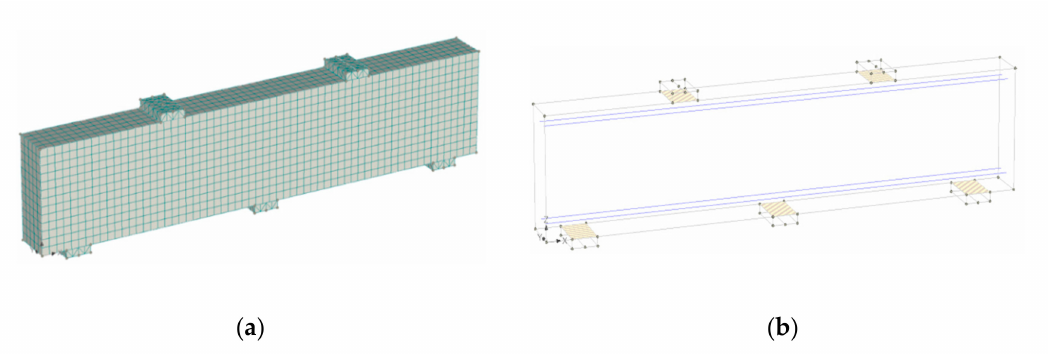
Figure 5. Generated 3D finite element modeling of beams: ( a ) Mesh configuration; ( b ) geometry and reinforcement